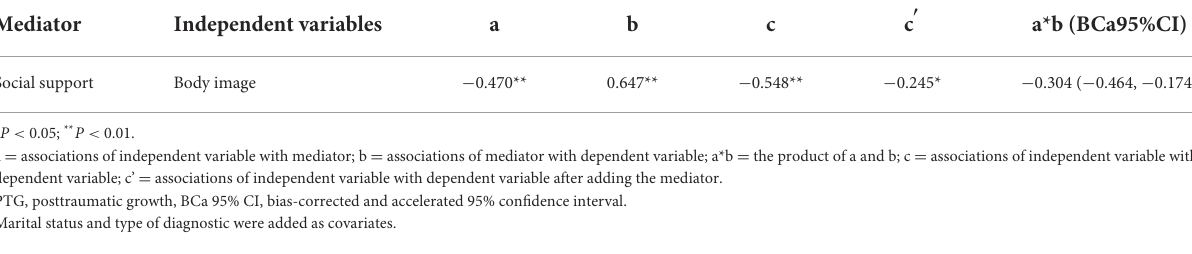
TABLE 5 Mediating role of social support between body image and